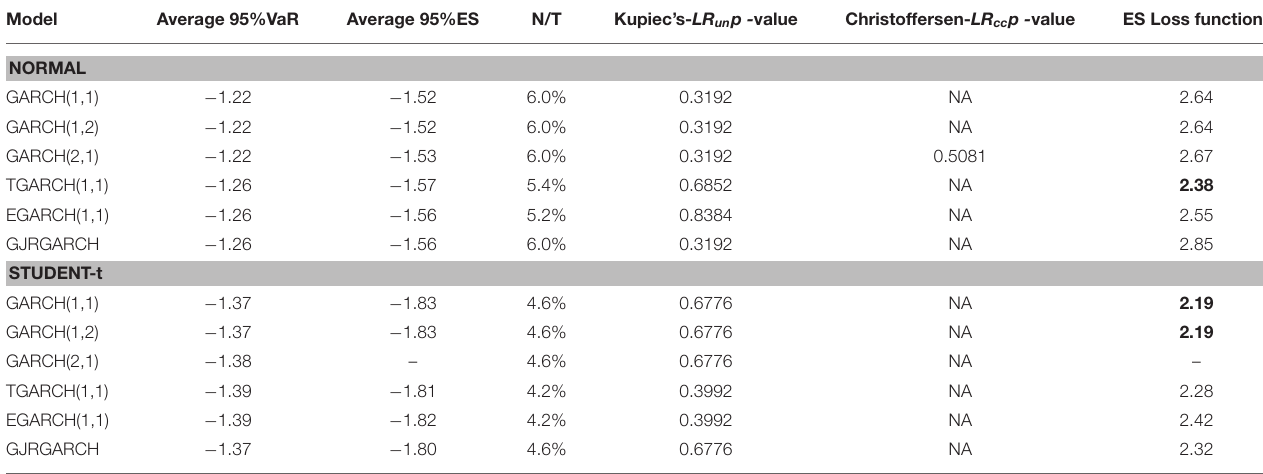
TABLE 10 | S&P500 equity index: 95%VaR and 95%ES average values of one-day-ahead forecasts, percentages of violation (N/T), Kupiec’s and Christoffersen’s p -values and ES loss function. Model